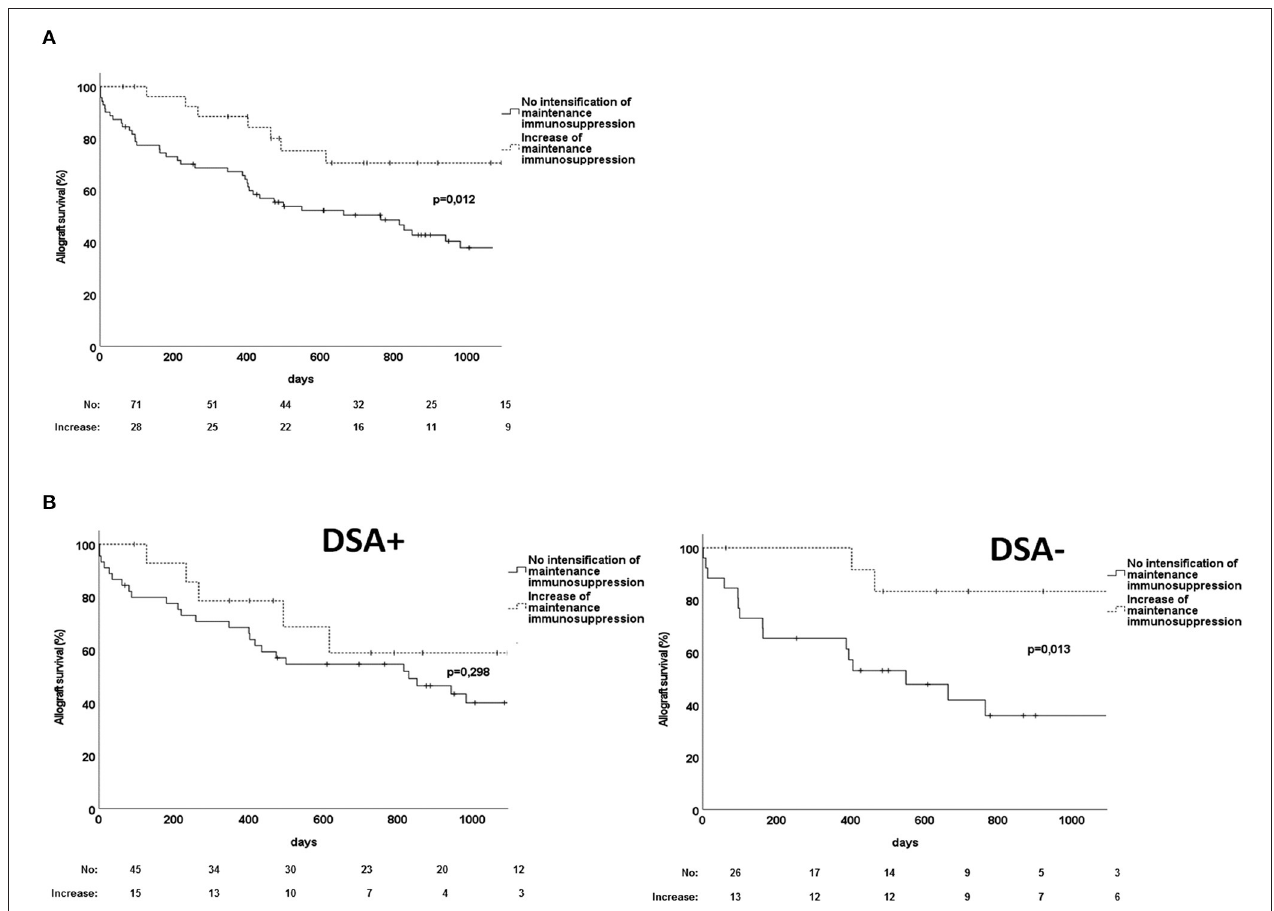
FIGURE 4 | Effect of the increase of maintenance immunosuppression on renal allograft survival among recipients with persistent antibody-mediated rejection. (A) Comparison of allograft survival between recipients who were treated with intensified maintenance immunosuppression vs. recipients without increase of maintenance immunosuppression. (B) Comparison of the effect of intensified maintenance immunosuppression on allograft survival between recipients with DSA-positive vs. DSA-negative ABMR. ABMR, antibody-mediated rejection; DSA, donor-specific antibody.